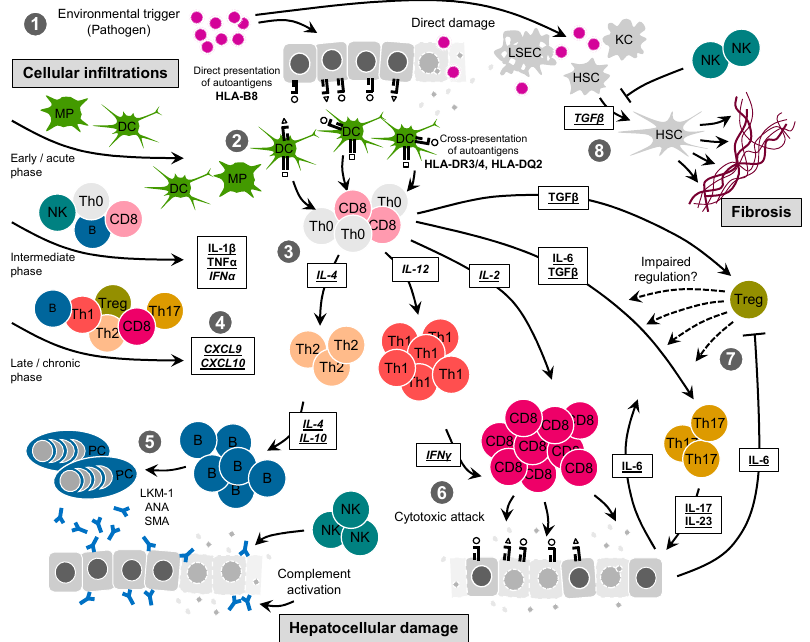
Figure 1. Putative immunopathogenesis of autoimmune hepatitis (AIH). This figure highlights the putative events involved in the immunopathogenesis of AIH as learned from clinical observations and experimental evaluations in animal models. Important inflammatory factors are marked according to whether the evidence was predominantly collected from clinical studies (underlined) or from animal models (italicized). Three main features of AIH are integrated, namely cellular infiltration, hepatocellular damage and hepatic fibrosis. ( 1 ) One or more environmental triggering events (for example, a liver-tropic pathogen infection) induces direct damage to hepatocytes and possibly also to other liver cells, such as liver-sinusoidal endothelial cells (LSEC), hepatic stellate cells (HSC), and Kupffer cells (KC); ( 2 ) Liver autoantigens are either directly presented by hepatocytes (mainly by major histocompatibility complex (MHC) class I molecules) or cross-presented by professional antigen-presenting cells, such as dendritic cells (DC) and macrophages (MP), (mainly by MHC class II molecules). Thereby, AIH is associated with the presence of HLA-B8, HLA-DR3, HLA-DR4, and HLA-DQ2. In parallel, the local acute release of alarm signals, such as monocyte-derived cytokines, are released resulting in the attraction and activation of Th0-type T cells, B cells, and natural killer (NK) cells; ( 3 ) The local pro-inflammatory milieu induces the differentiation of Th0-type T cells predominantly into Th1-type (by interleukin (IL)-12) and Th-17-type (by IL-6 and TGF β ) T cells. However, due to the expression of IL-4, some T cells also acquire a Th2-type phenotype; ( 4 ) During this phase, the elevated expression of chemokines, such as chemokine (C-X-C motif) ligand (CXCL9) and CXCL10, leads to the attraction of a larger number of immune cells including liver autoantigen-specific T cells as well as non-specific bystander T cells from the circulation to the liver; ( 5 ) Hepatocyte damage may be precipitated by specific antibodies released by plasma cells (PC), such as liver microsomal antibodies type 1 (LKM-1), anti-nuclear antibodies (ANA), and anti-smooth muscle actin (SMA), that decorate hepatocytes expressing autoantigens at the surface and lead to complement activation and NK cell-mediated killing. Thereby, Th2-type T cells provide help via IL-4 and IL-10 expression; ( 6 ) Predominant hepatocyte damage seems to originate from cluster of differentiation (CD)8 T cell-mediated killing via perforin/granzyme B-mediated cell lysis or by the release of toxins, such as tumor necrosis factor α (TNF α ) and interferon γ (IFN γ ); ( 7 ) Th17-type T cells, via IL-17 and IL-23 release, induce the production of IL-6 by the hepatocytes, which further stimulate Th17-type T cell generation, blocking regulatory T cells (Treg). An impaired immune regulation by Treg is, however, controversial; ( 8 ) Besides being an important differentiation factor for Th17-type T cells and Treg, transforming growth factor β (TGF β ) is also required for an activation of HSC and subsequently for the exacerbated deposition of collagen observed in hepatic fibrosis. NK cells have been shown to block HSC activation.